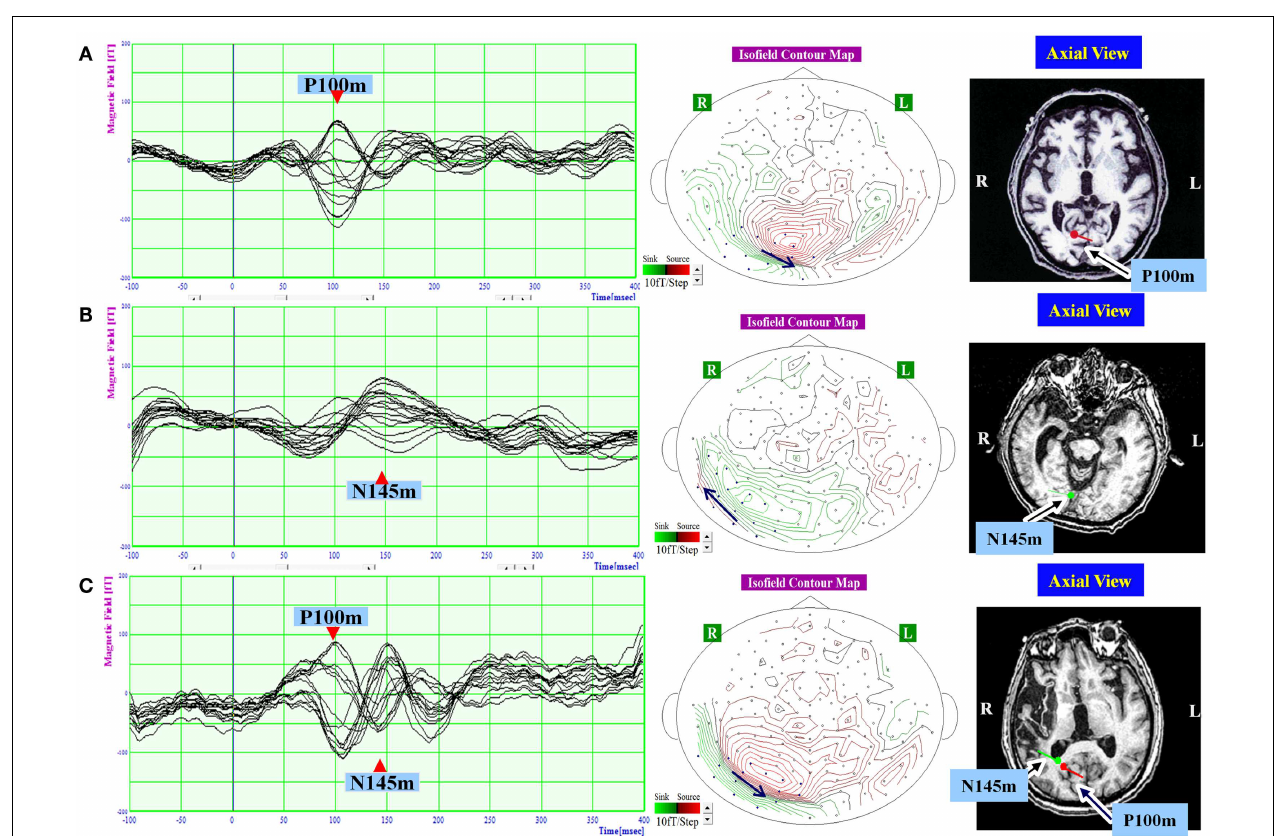
A black arrow indicates an expected location and direction of ECD. Small circles indicate distribution of recording sensors. Blue circles indicate selected 16 channels. Middle: the equivalent current dipoles (ECDs) superimposed on axial magnetic resonance images. Red represents the P100m component of theVEF; green represents the N145m component of theVEF.The dot represents dipole location, and the bar represents dipole direction.The P100m component was evident in Patient 1 (A) and Patient 3 (C) .The N145m component was evident in Patient 2 (B) and Patient 3 (C) . All observed components were located in the occipital lobe. The P100m components were directed medially, and the N145m components were directed laterally.